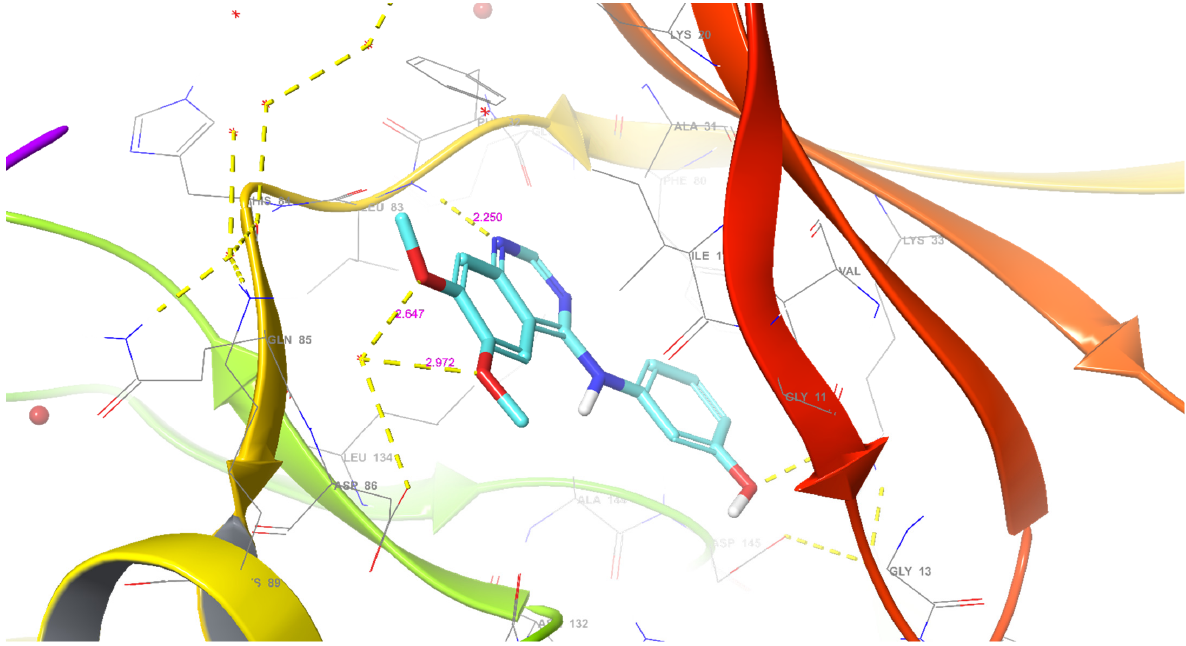
Figure 5. Three-dimensional binding interactions of DTQ within the ATP binding pocket of CDK2. Hydrogen bonds (yellow dotted lines), hydrogen atoms (white), nitrogen atoms (blue), and oxygen atoms (red).